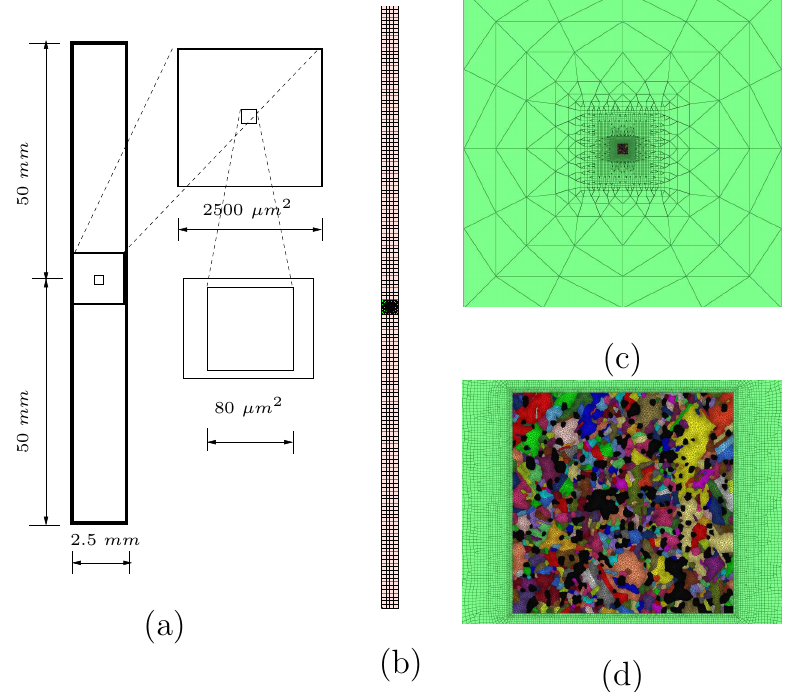
particles (from 2